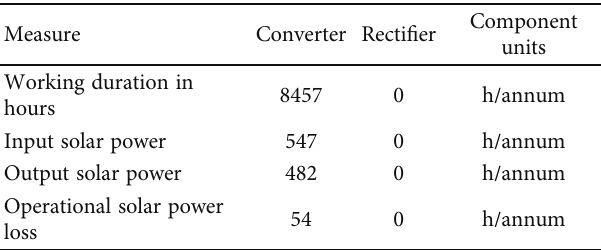
Table 2: Annual power loss of solar electrical